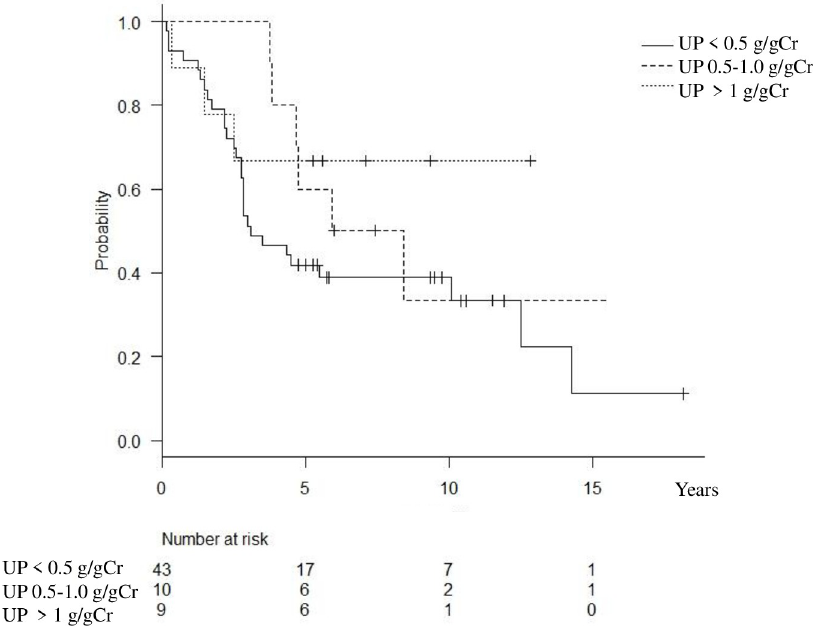
Fig 1. Kaplan-Meier plot of hematuria remission, defined by disappearance of microscopically visible urine red blood cells < 5 /HPF in urine sediment.